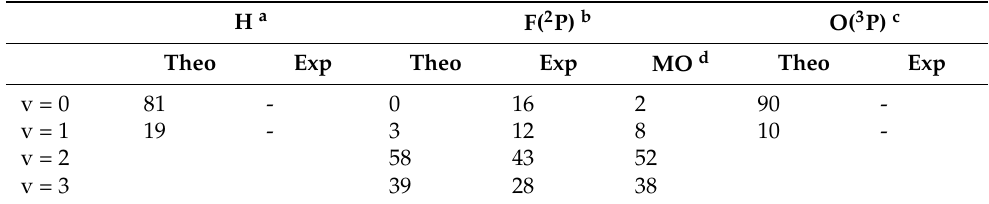
Table 4. Theoretical/experimental diatomic, HX(v), product vibrational distribution. Values in